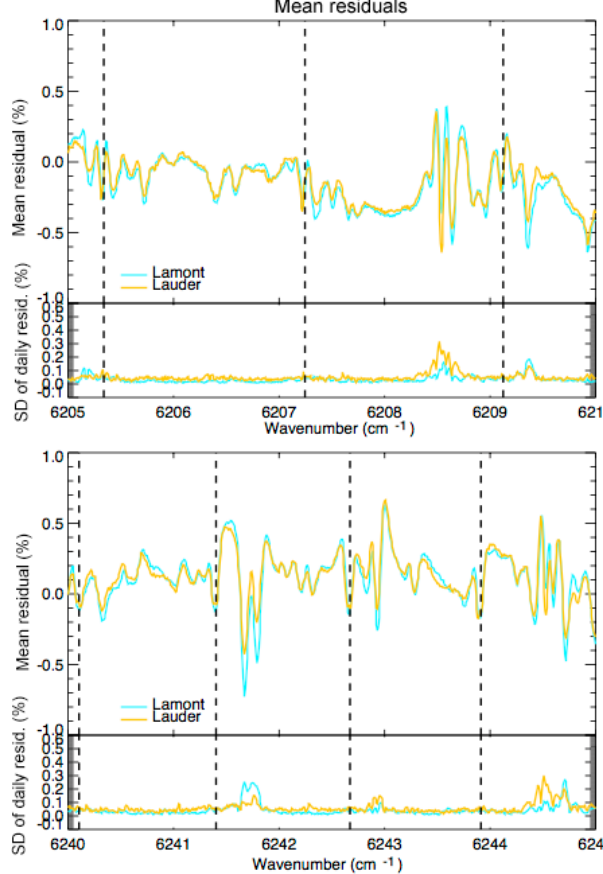
Figure 12. Mean and standard deviation of residuals in selected spectral intervals, for measurements with air mass <2.